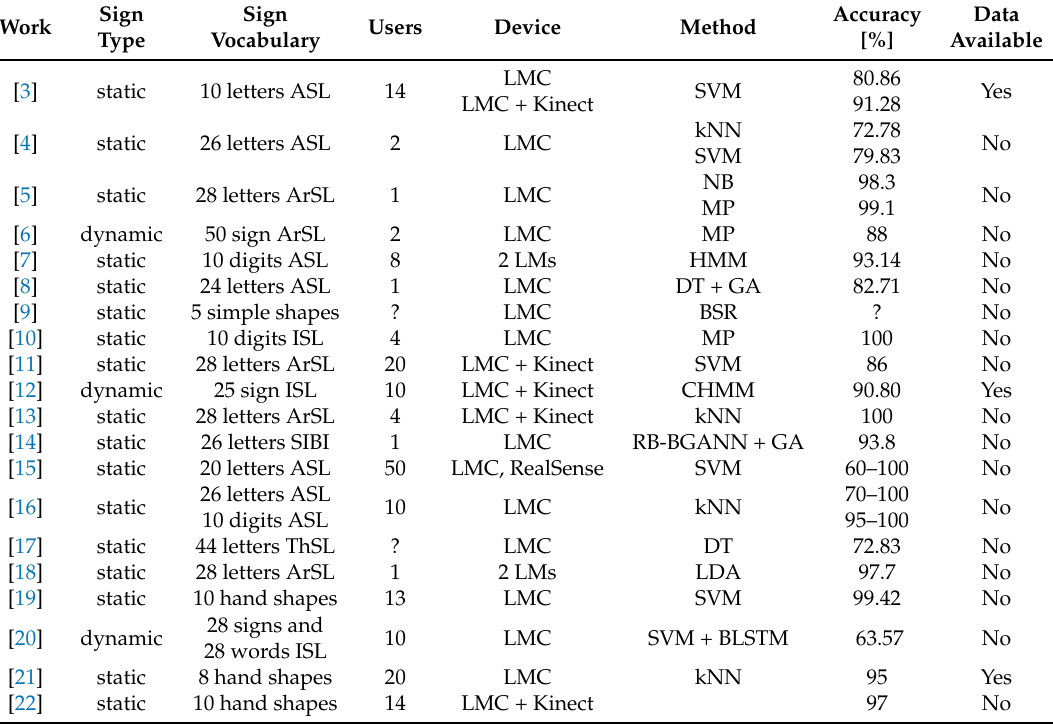
Table 1. Recent works on handshape recognition using skeletal